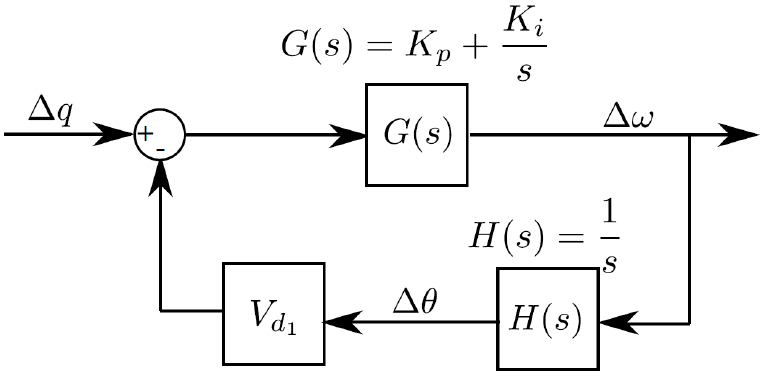
Figure 2. Phase locked loop (PLL) small signal closed loop transfer function diagram.